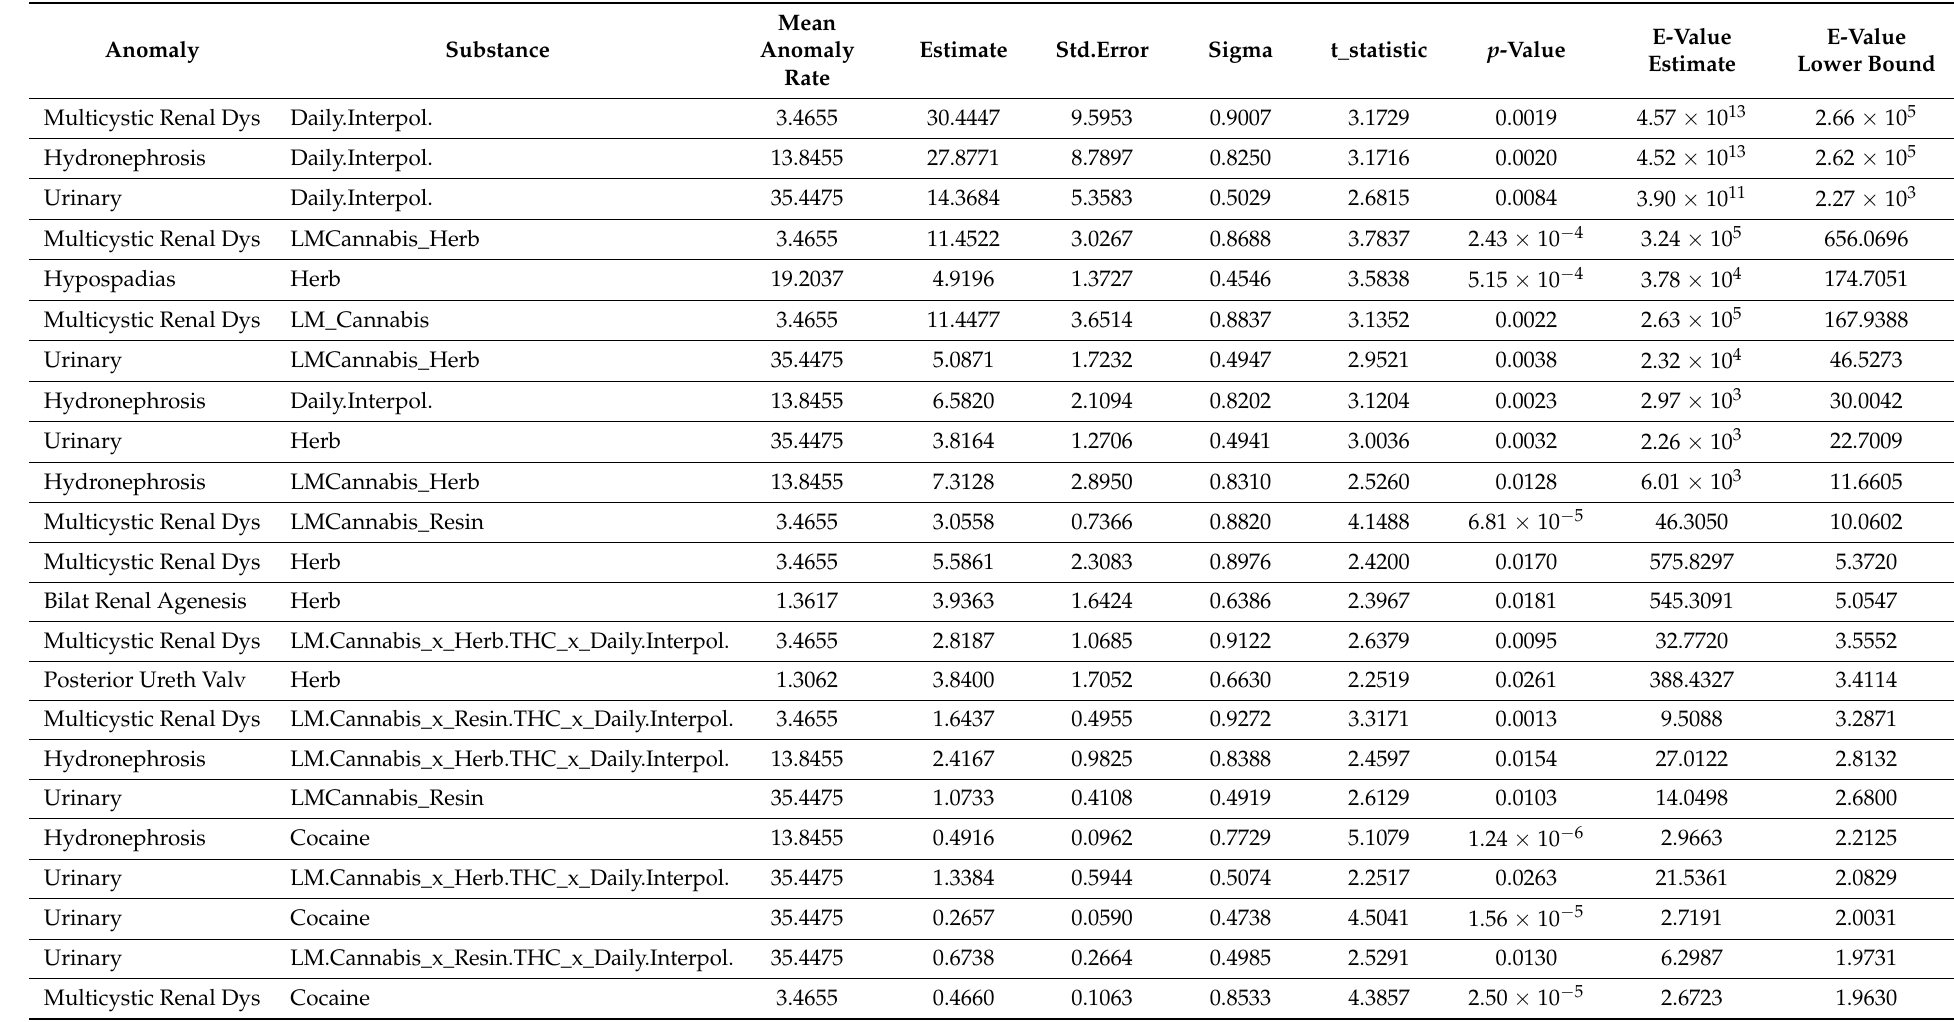
Table 1. Positive Significant Slopes from Bivariate Linear